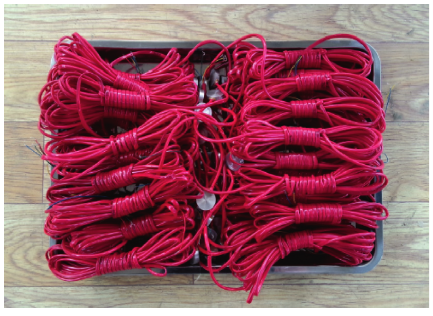
Figure 8: Earth pressure gauge.